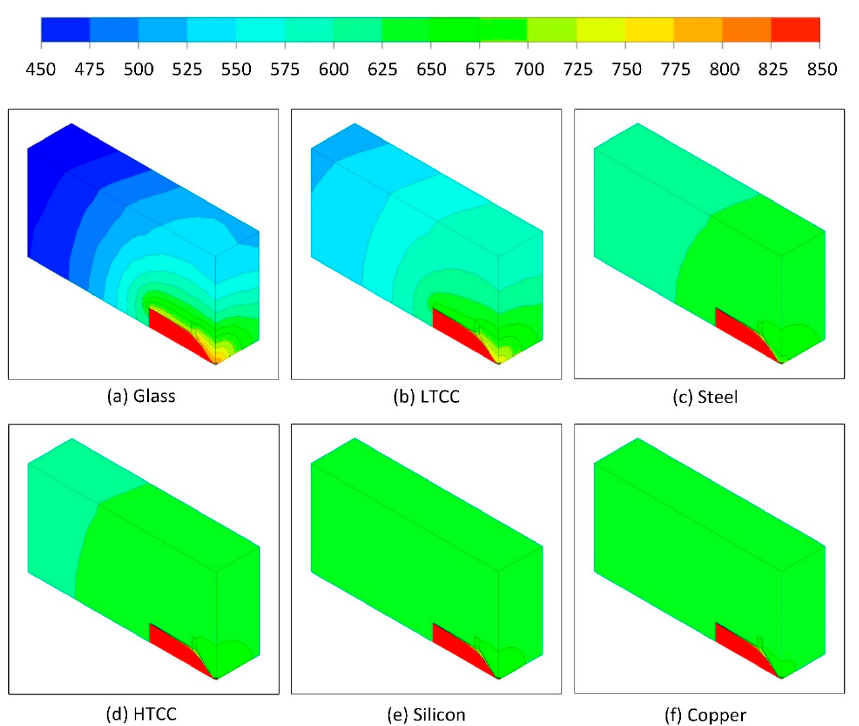
Figure 8. Comparison of the average temperature on the outside surface and that inside the chamber inlet of the microthruster with materials of various levels of thermal diffusivity and different pro- pellant enthalpies (85, 90, and 95 wt% hydrogen peroxide).